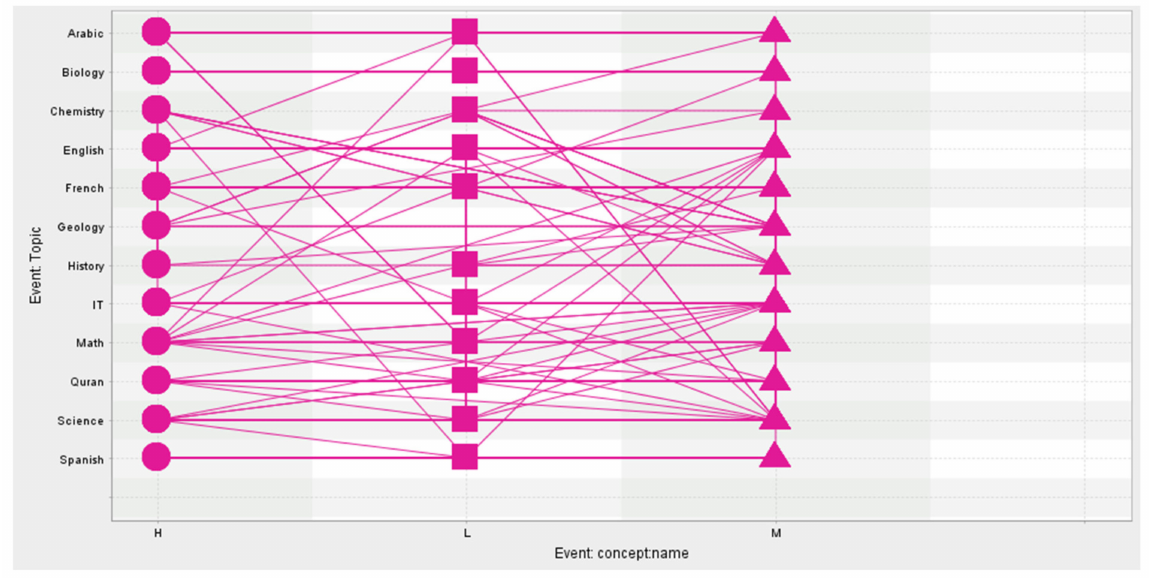
Figure 9. Frequency of distribution between class and topic in different shapes for events.